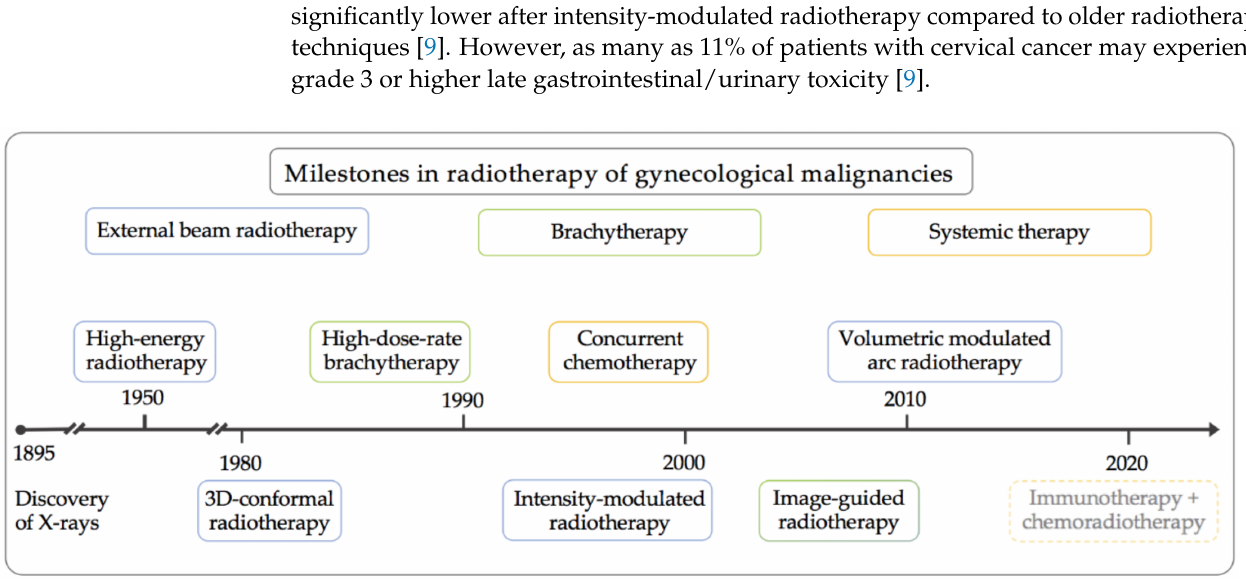
Figure 1. Milestones in radiotherapy for gynecological malignancies. A schematic timeline showing innovations in radiotherapy, including external beam radiotherapy, brachytherapy, and systemic therapy.